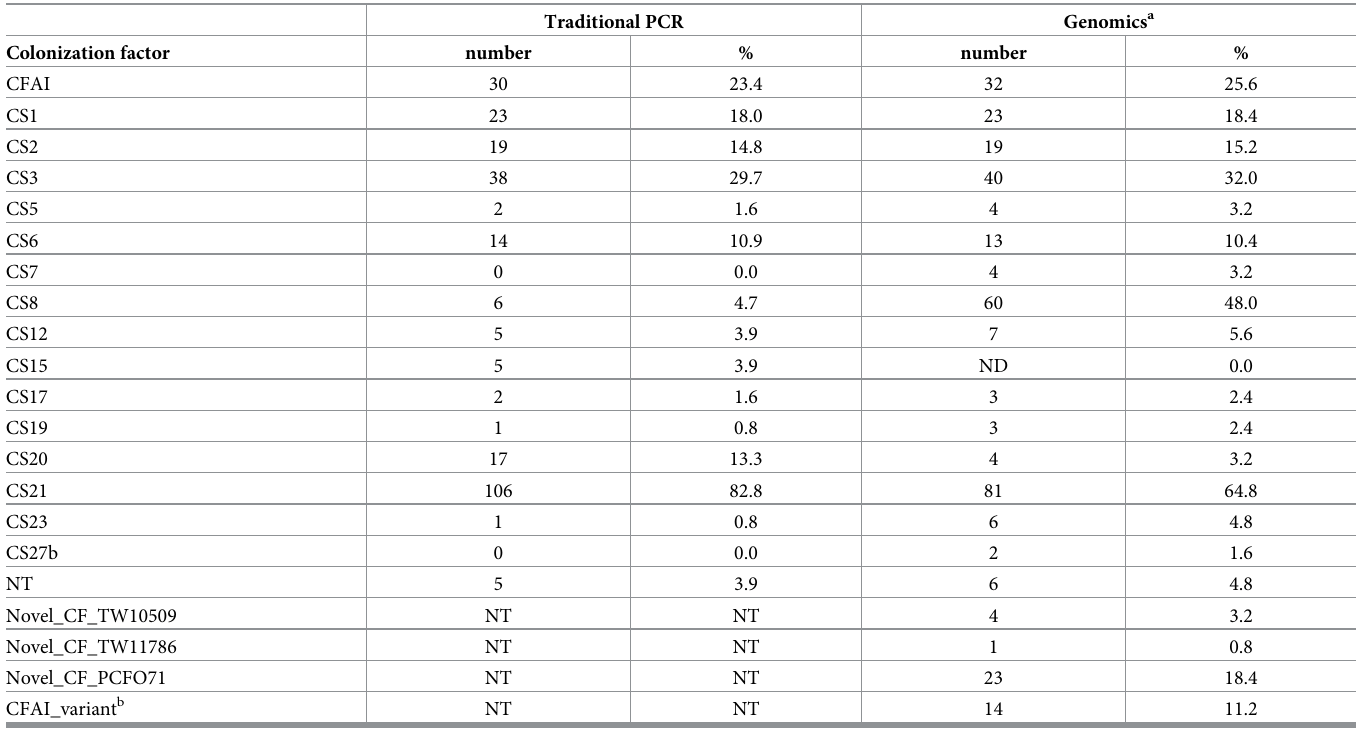
Table 3. Colonization factor prevalence a